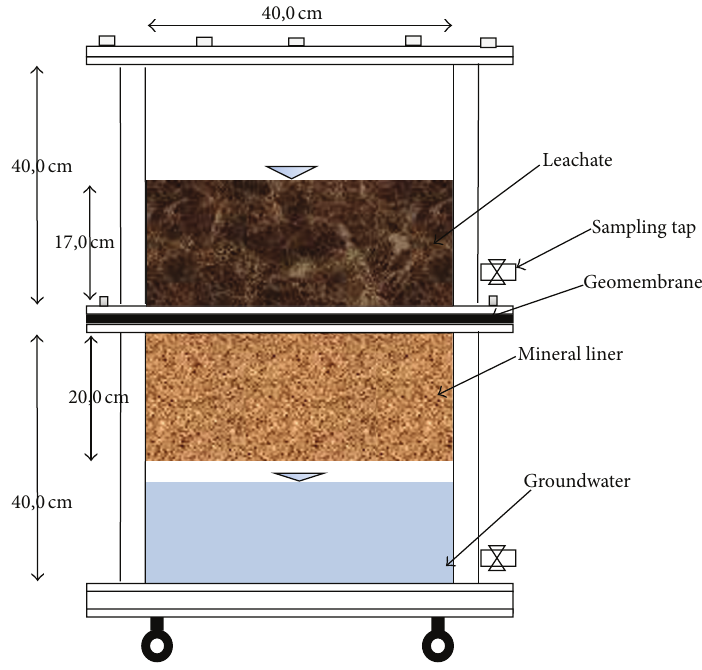
Figure 1: Reactors used in the